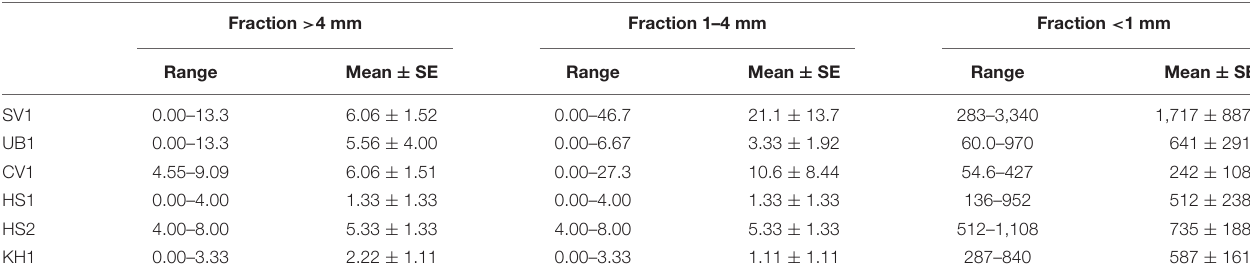
TABLE 5 | Number of microplastics in three size fractions per L of dry sediment collected from the six coastal sites around Macao, expressed as range and mean ± standard error of the mean (SE) (see Figure 1 for the site abbreviation).